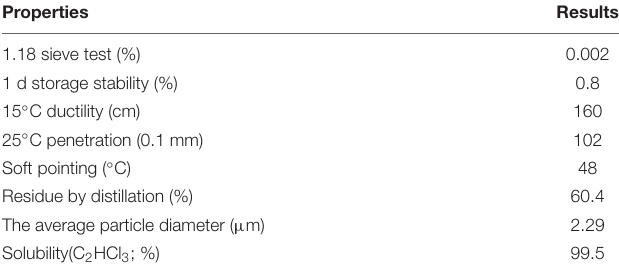
TABLE 1 | Properties of asphalt